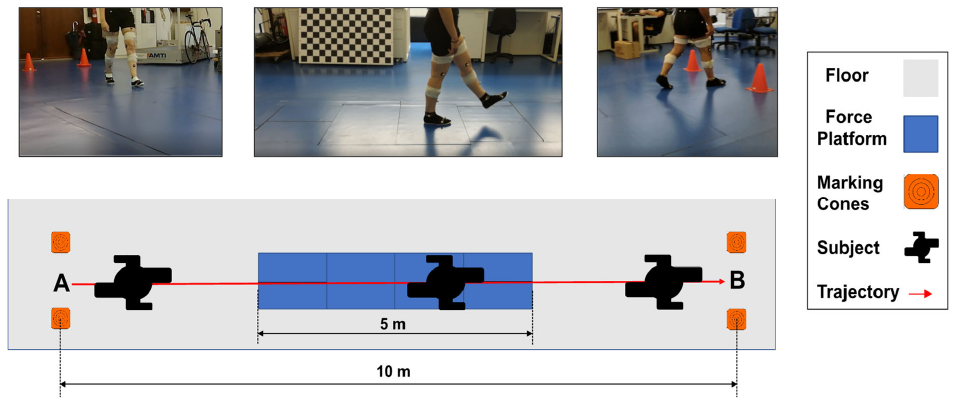
Figure 2. Data acquisition scenario, in which points A and B represent the beginning and the end positions of each trial, respectively.